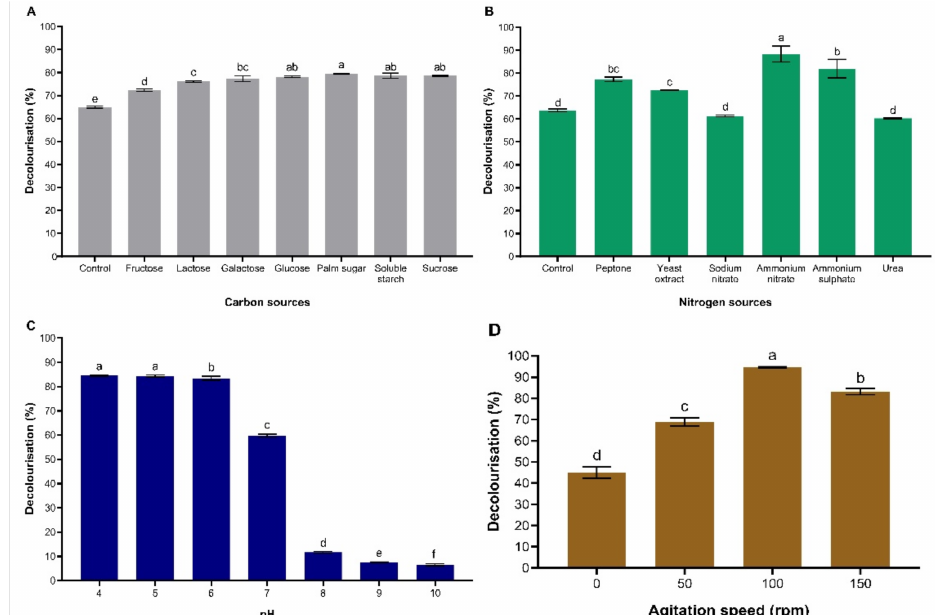
Figure 3. Effects of carbon ( A ), nitrogen ( B ), pH ( C ), and agitation speed ( D ) on decolourisation of textile dyes by immobilisation of T. hirsuta PW17-41 at 4% ( v/v ) concentration after 48 h. Error bars indicate the standard deviation and letters a–f indicate statistically significant differences between groups analysed via one-way ANOVA ( n = 3, p <